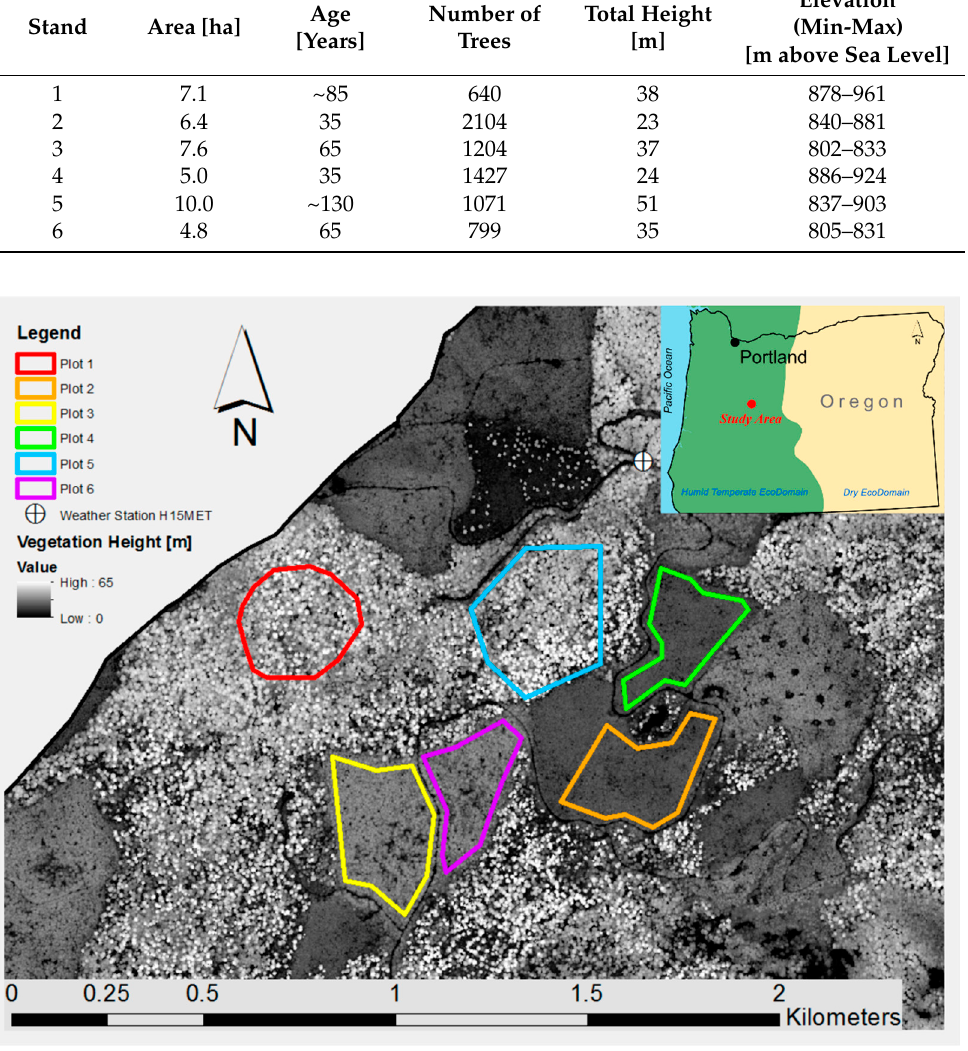
Figure 1. The six areas inside HJ Andrews for which the water canopy analysis is executed as well as the location of the weather station H15MET.